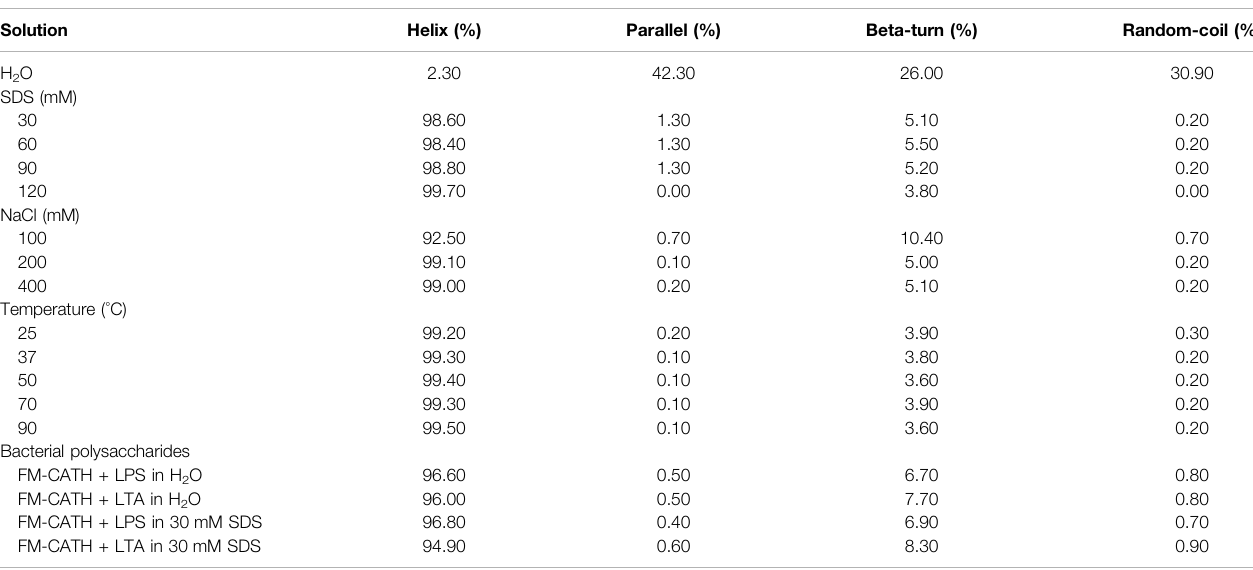
TABLE 1 | The secondary structure components of FM-CATH in different solution.